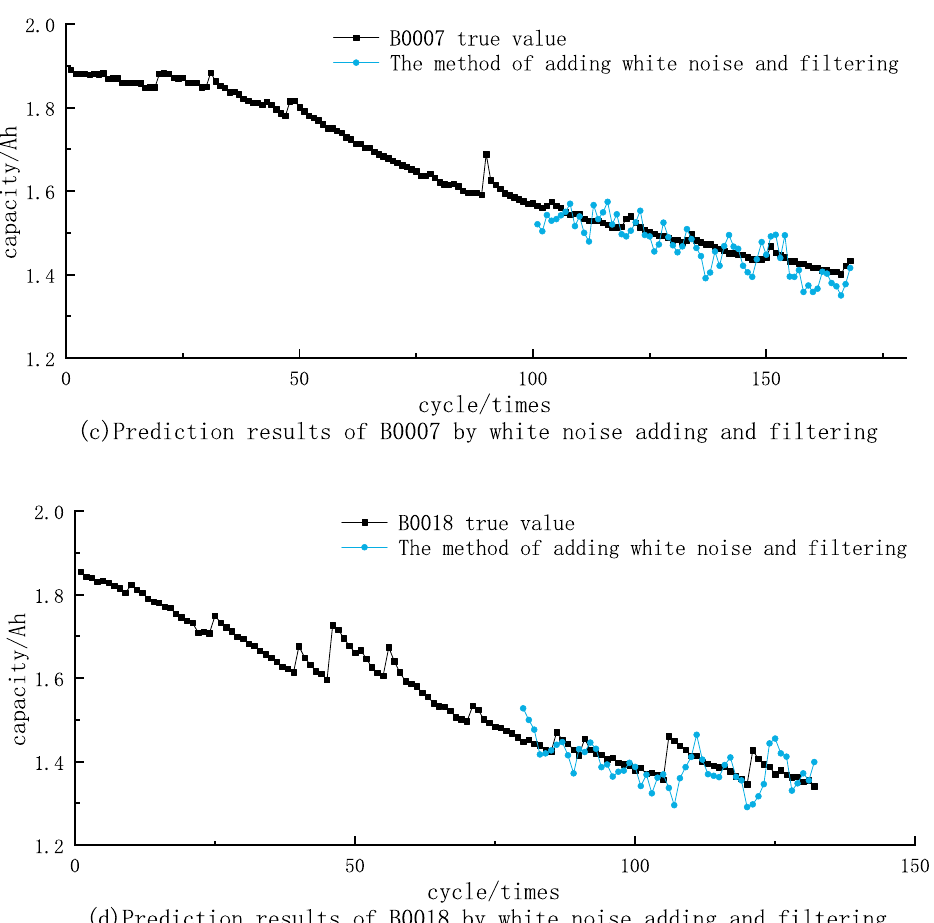
Figure 3. Prediction results with white noise added and